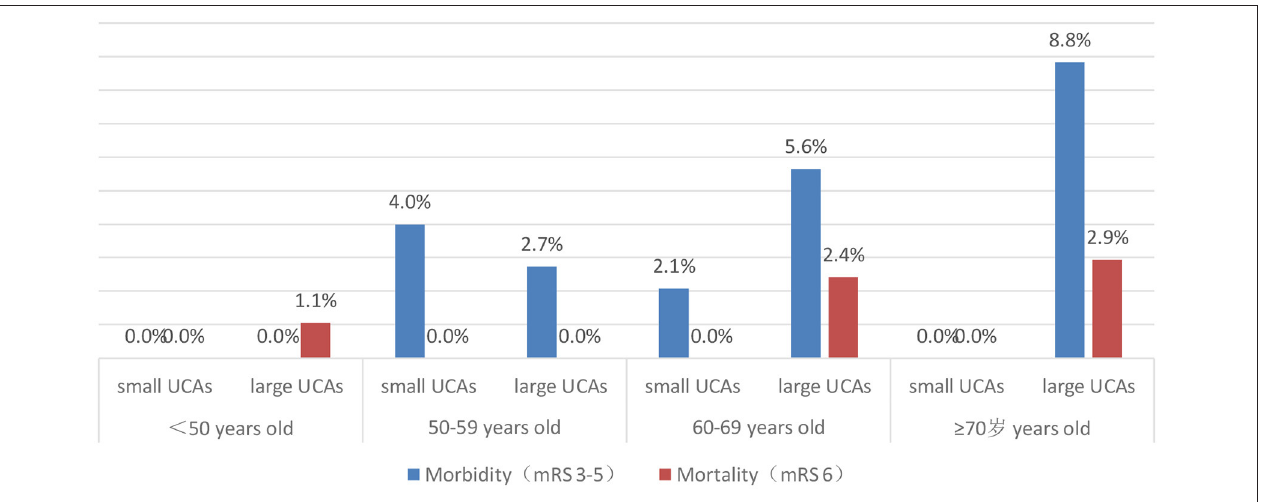
had more treatment-related complications and are at high risk of poor